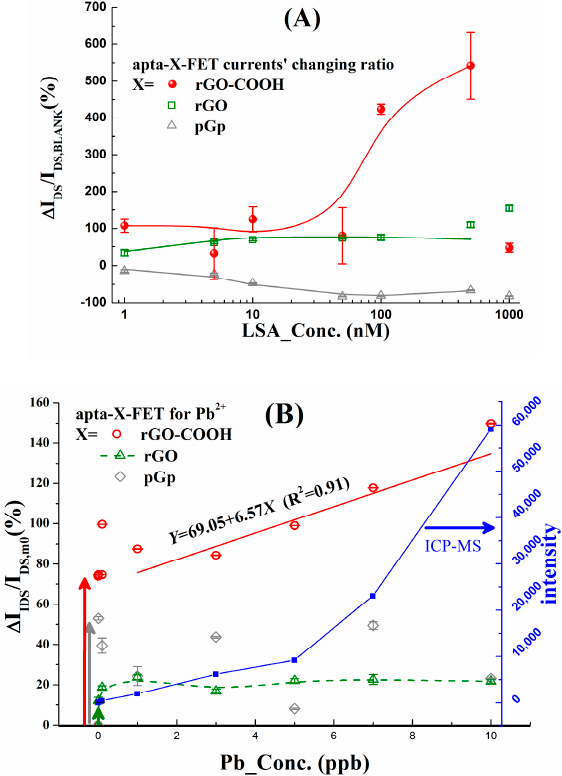
Figure 5. Response for LSA immobilization ( A ) and Pb 2 + ( B ). Meanwhile, ICP-MS examinations